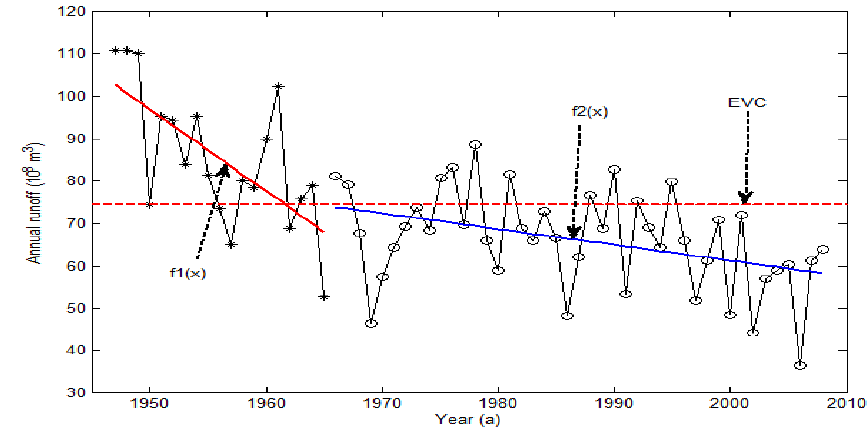
Figure 1. schematic diagram to introduce how to reconstruct the hydrological series. The red solid line is the trend line of sub-sample; the blue solid line is the trend line of sub-sample; the red imaginary line means EVC.